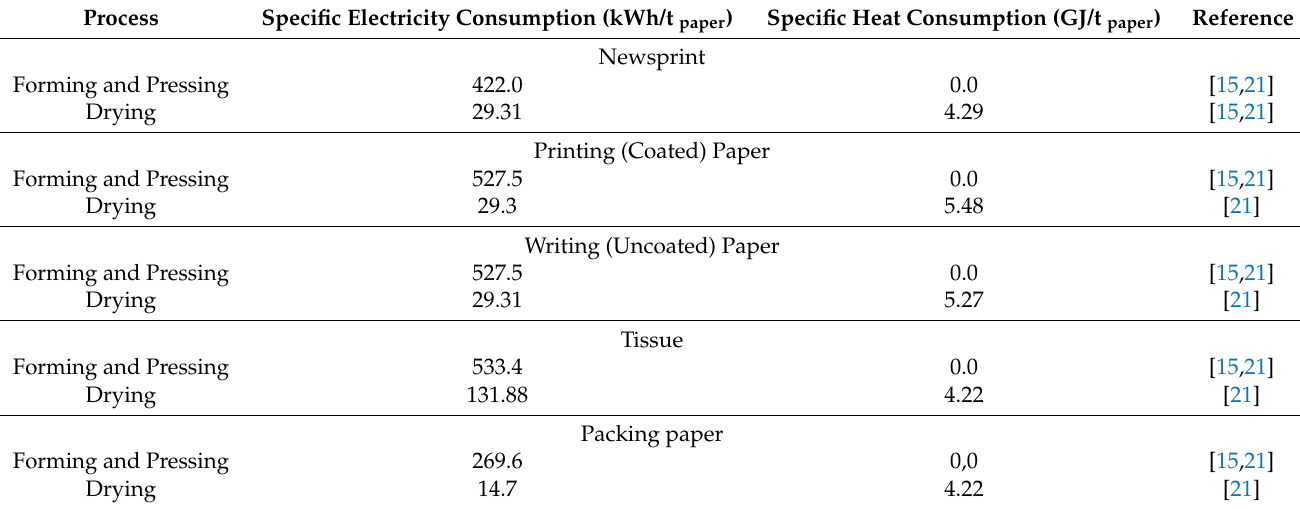
Table 3. Specific electricity and heat consumption of the paper processes in pulp and paper production.